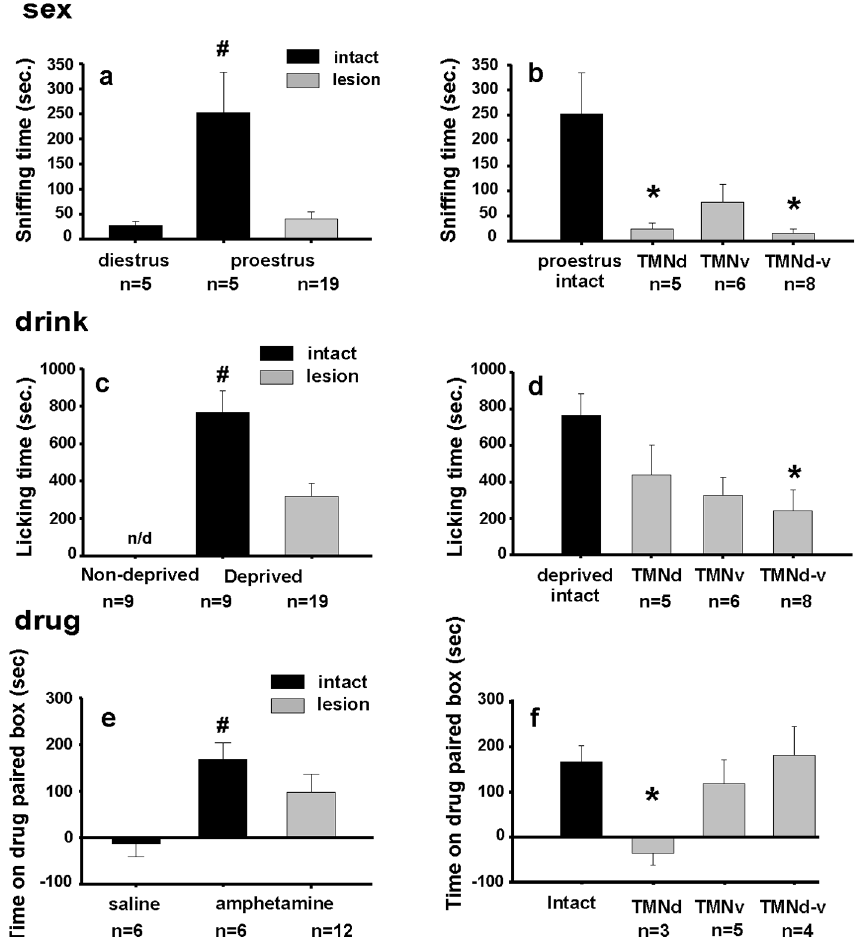
Fig 4. Effect of TMN lesion on appetitive behavior. ( a) TMN lesion decreased the sniffing time of male rats challenged by a receptive female (proestrus) to a level similar to that elicited by non-receptive females (diestrus).( b) dorsal TMN and dorsal plus ventral TMN lesions were sufficient to reduce sexual appetitive behavior respect to the intact group. ( c) TMN lesion decreased licking time of water deprived animals enticed by an empty drinking bottle. ( d) The lesion had to involve both TMN divisions to be effective on drinking behavior. ( e) TMN lesion decreased the time spent in the amphetamine-paired box in conditioned rats. ( f), rats with a dorsal TMN lesion showed the largest drop in appetitive behavior directed to obtain amphetamine. ANOVA of Ranks (Kruskall Wallis) followed by a post-hoc of multiple comparison, Dunn's method. * indicates p < 0.05 respect to intact rats, # p < 0.05 respect to the two other conditions. n/d, not